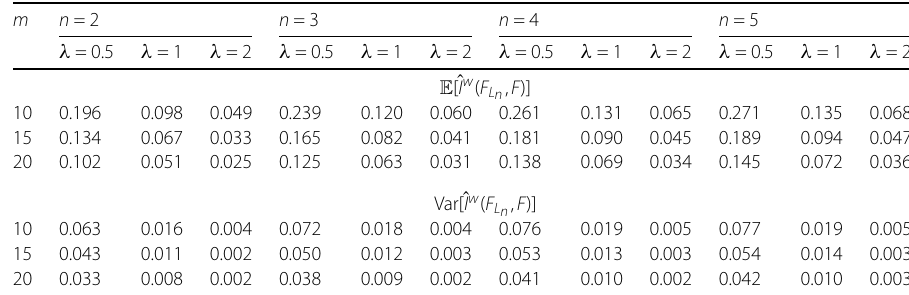
, F )] and Var[ ˆ I w ( F L n